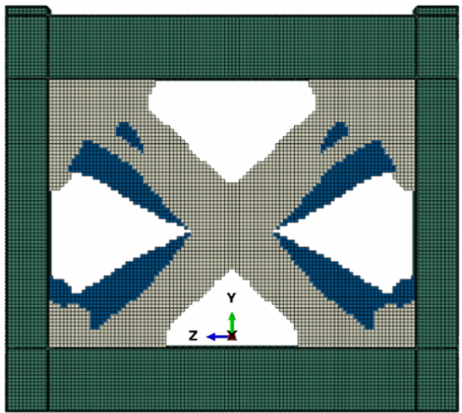
Figure 12. Symmetric distribution of stiffeners.